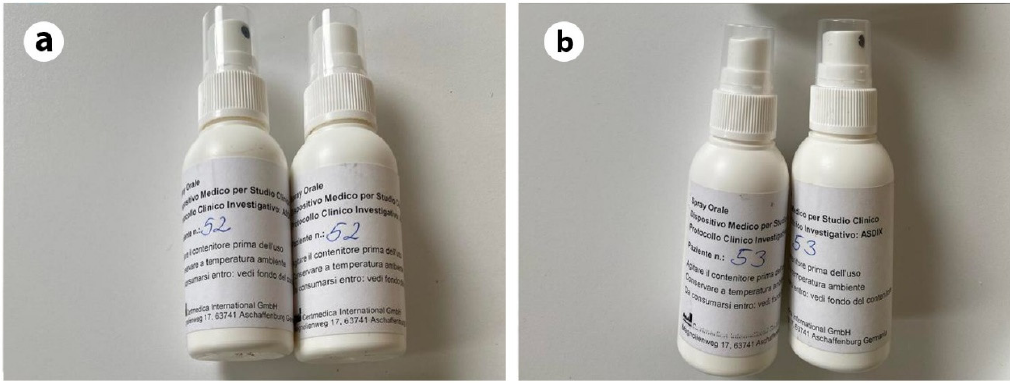
Figure 2. Spray bottles identical for the aldiamed ® spray (AS) and placebo spray (PS) groups ( a , b ).